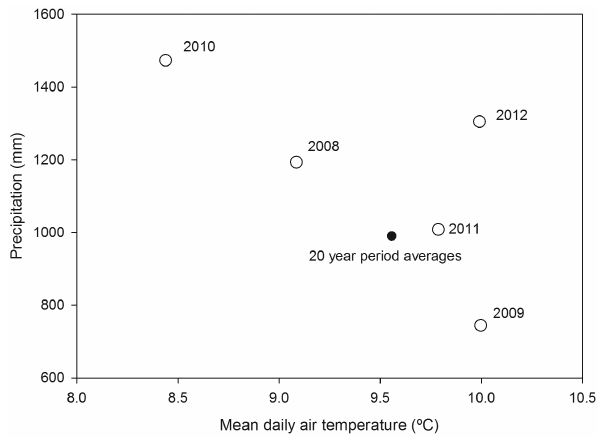
Figure 2. Cumulative precipitation versus average daily air temper- ature for the period May–November.